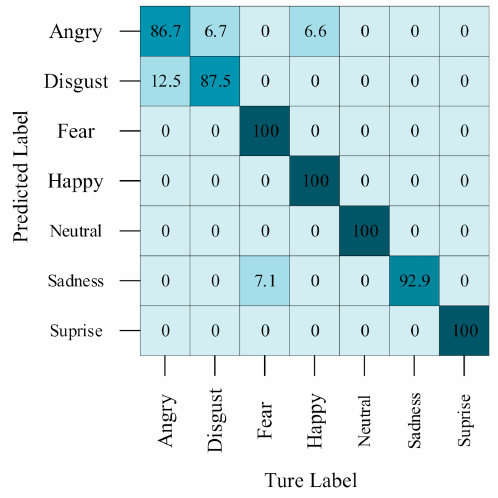
Figure 7. Test confusion matrix of